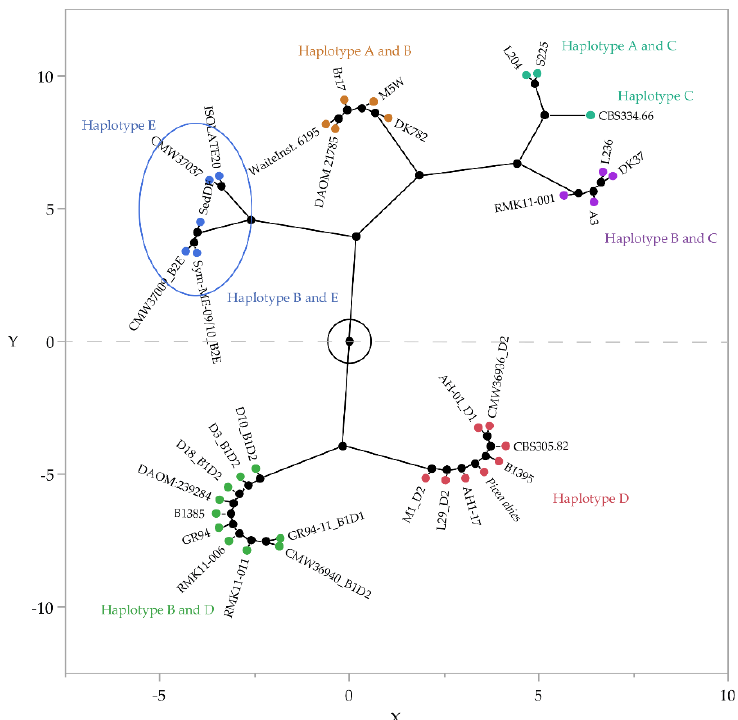
Figure 4. Hierarchical clustering analysis and constellation plot based on 35 isolates from the GenBank (Supplementary Table S1, unique sequence), and relatedness of haplotypes in the Amylostereum areolatum isolates from native and non-native Sirex specimens, from multiple locations in China. The plot arranges the A. areolatum isolates as endpoints, and each cluster join as a new point, whereas the lines represent membership in a cluster. The length of a line between cluster joins approximates the distance between the clusters that were joined, where X- and Y-axes enable comparison of the relative distance between clusters; the longer the lines, the greater the distance between the clusters. The axis scaling, orientation of points, and angles of the lines on the constellation plot are arbitrary, with no assigned unit in SAS-JMP pro version 16.0.0.